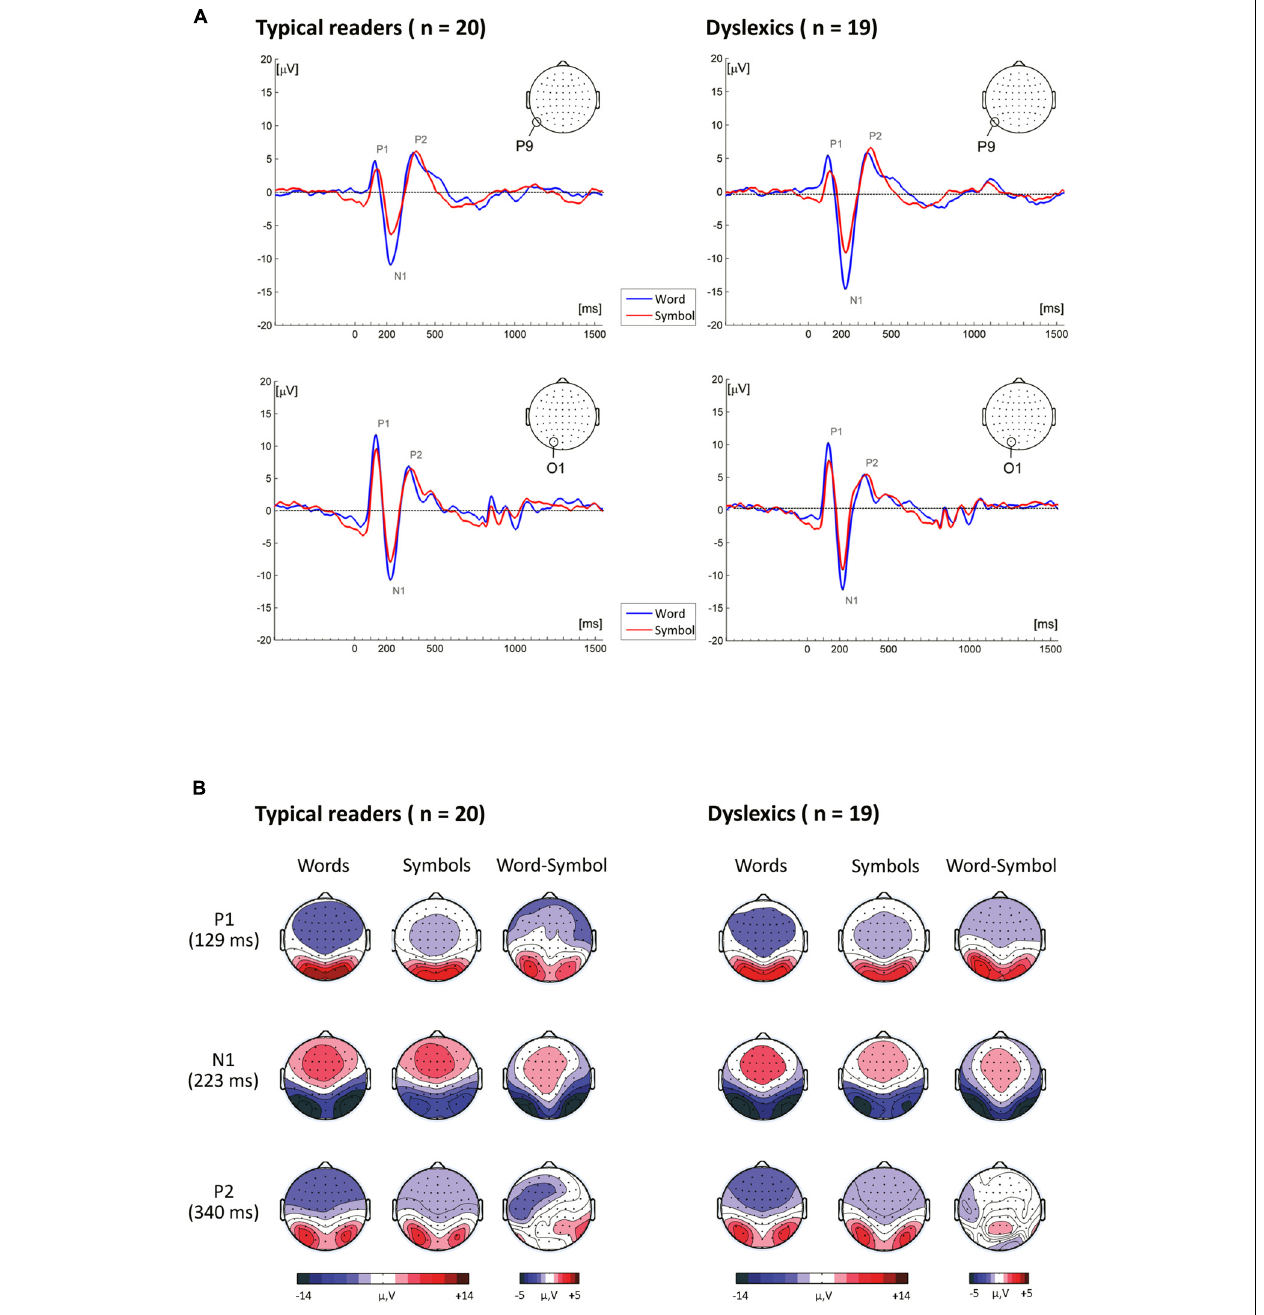
FIGURE 3 | (A) Event-related brain potentials to word and symbol strings at P9 and O1. (B) Topographical maps showing the time course of neural activity following stimulus presentation.